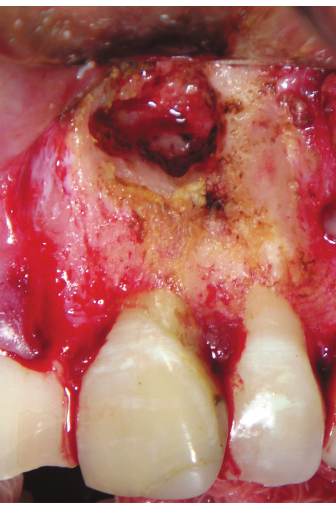
Figure 4: A postoperative radiograph shows the proper retrograde placement of thermoplasticized gutta-percha in direct contact with the resin located inside the main